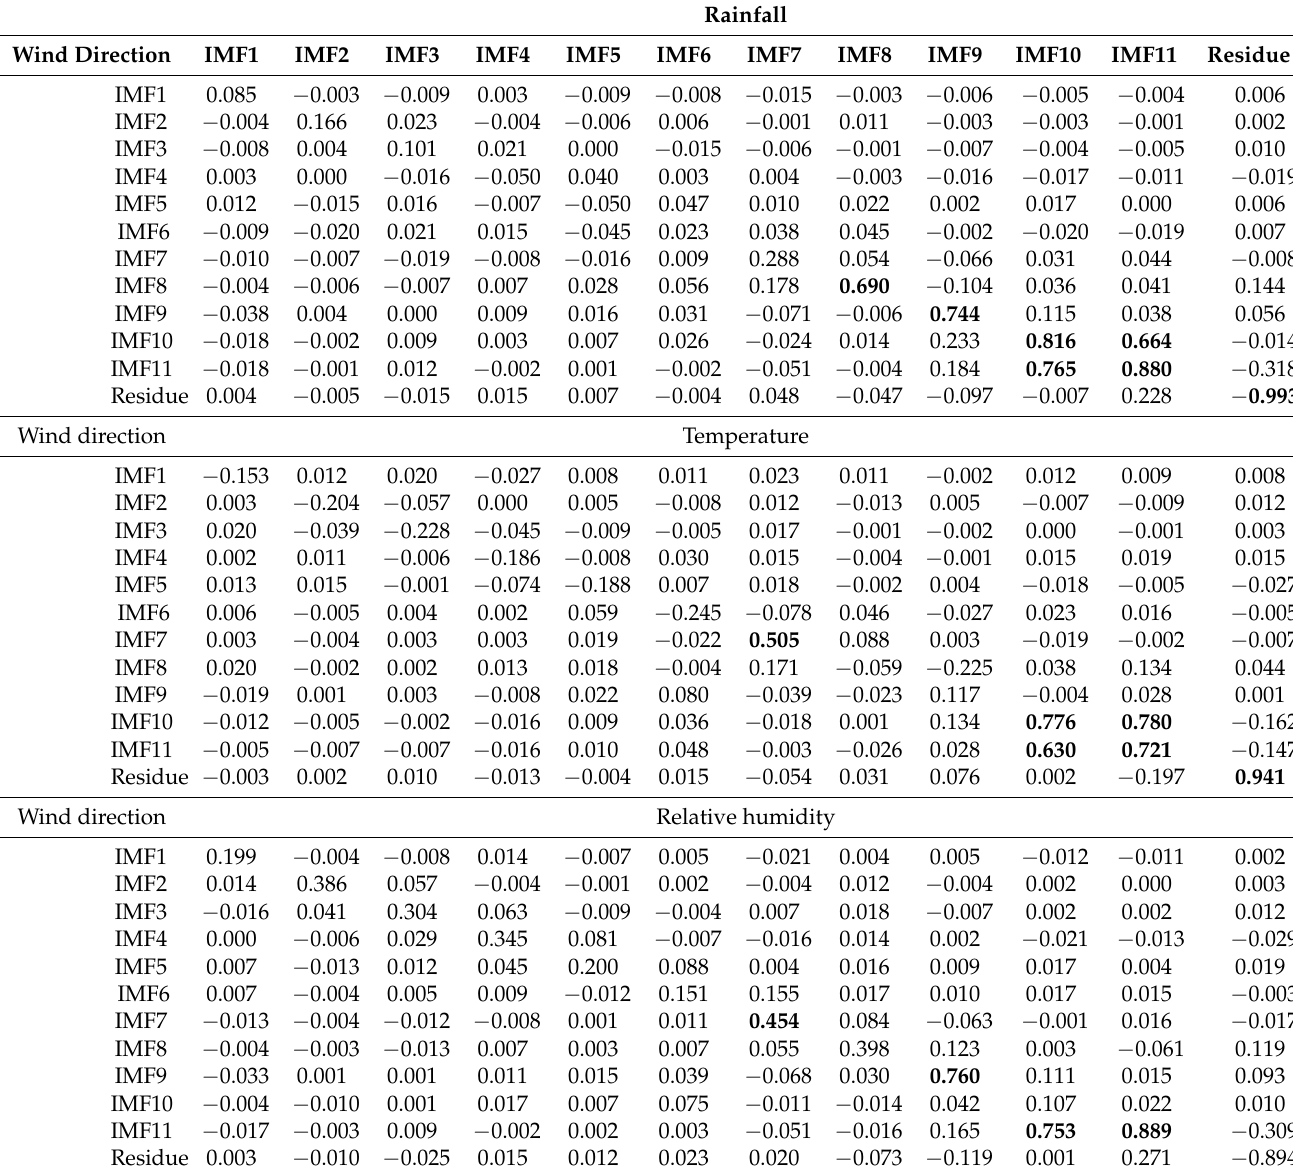
Table 3. Correlation between the modes of wind direction and the modes of rainfall, temperature, relative humidity, solar radiation and wind speed. Significant correlations at the 5% level are marked in